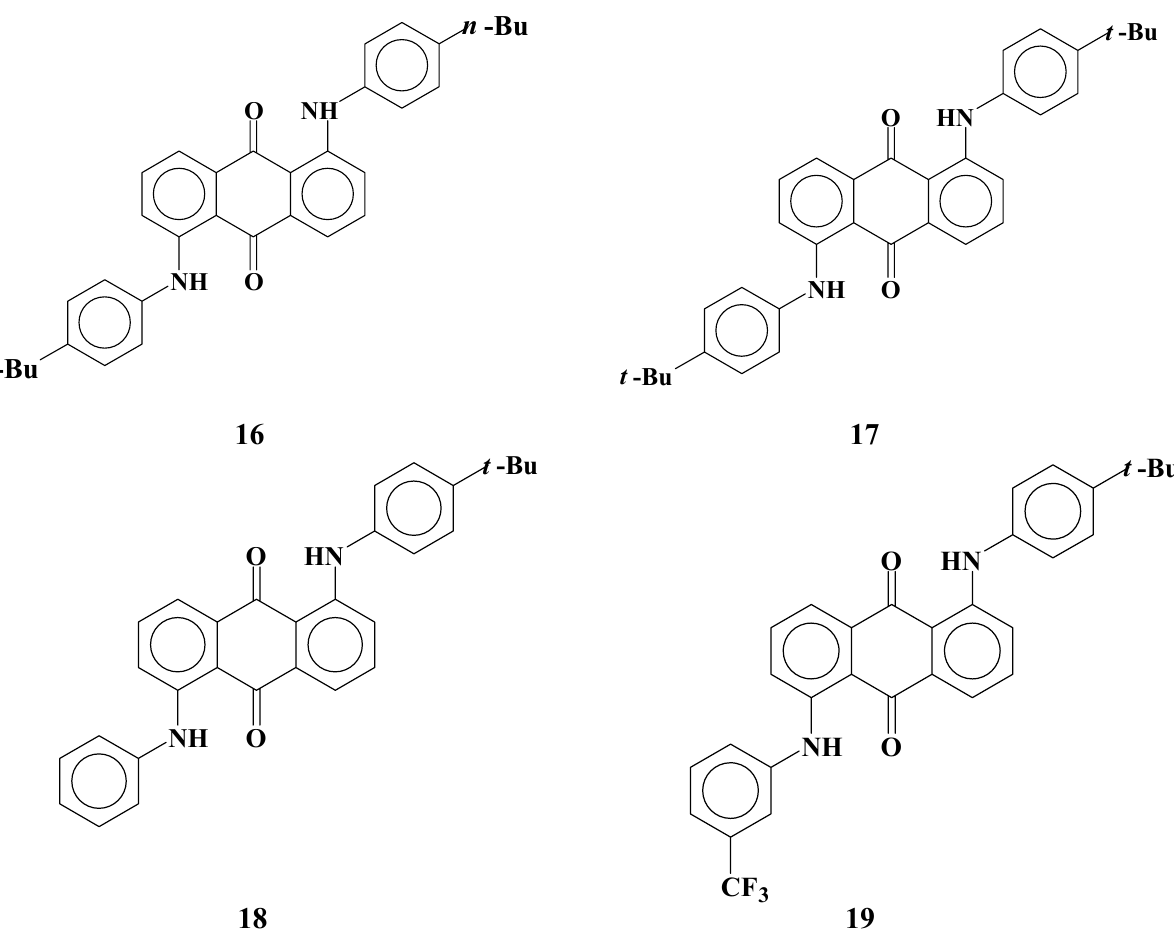
Figure 12. The molecular structures of magenta anthraquinone dichroic dyes with two anilino groups at the 1 and 5 positions.